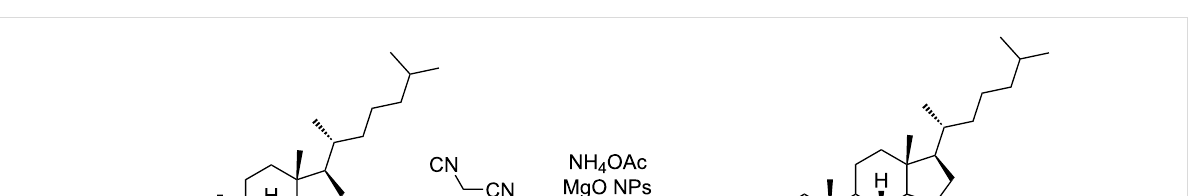
Figure 9: Biologically active molecules containing pyridine moiety.